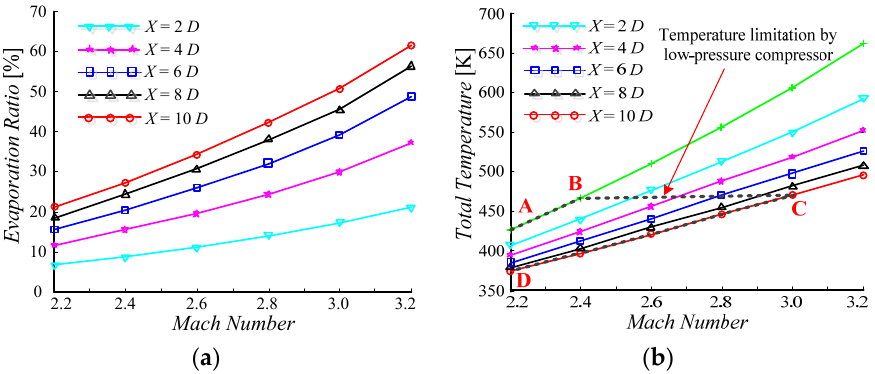
Figure 14. Distribution of evaporation ratio and total temperature with different inlet length at different Mach number ( a ) evaporation ratio with WAR = 0.09, ( b ) total temperature of the air with WAR = 0.09.